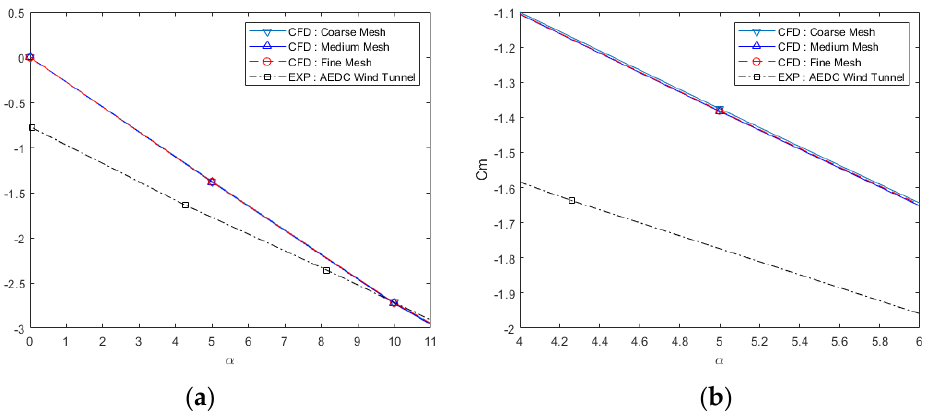
Figure 7. Mesh convergency test for coarse, medium, and fine mesh model; ( a ) angle of attack 0 to 10 deg; ( b ) detailed view of angle of attack of 5 deg.